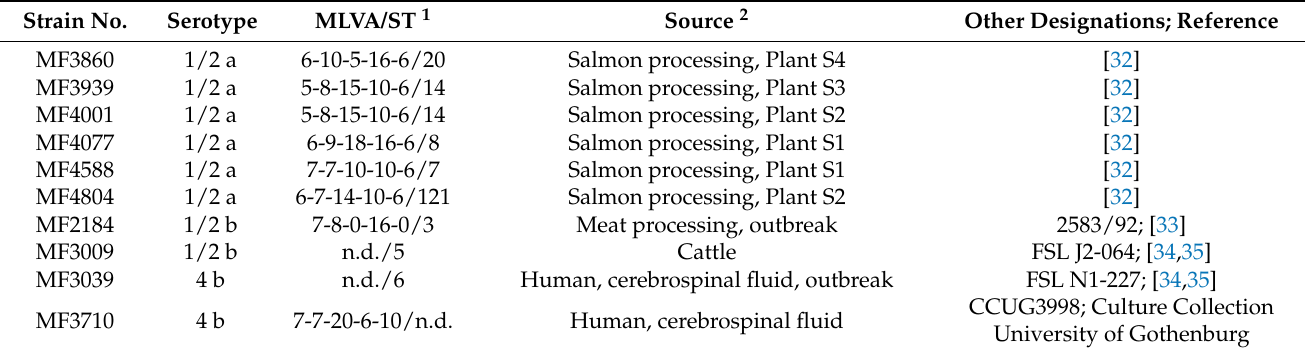
Table 3. Listeria monocytogenes